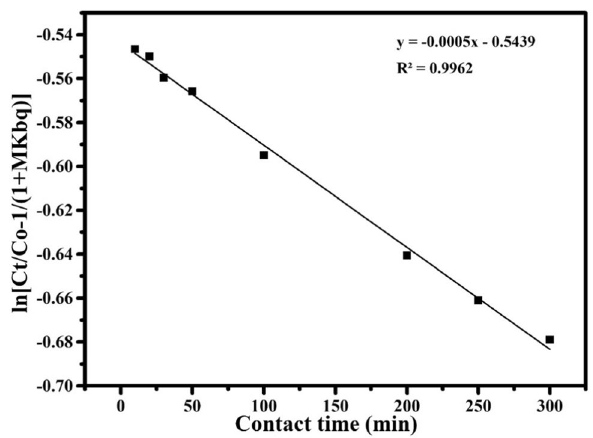
Fig. 13 Mass transfer plot for the MB dye adsorption on the PBF sur- face